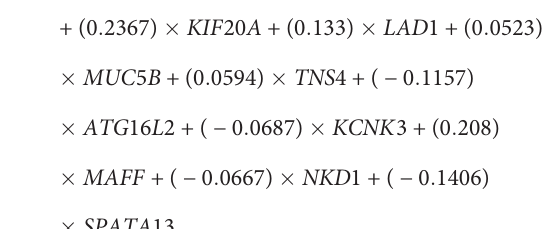
TABLE 1 | Kaplan-Meier analysis of 24 key genes. Genes